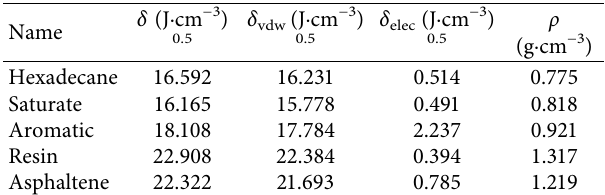
Table 3: Solubility parameters and densities of each component in low-sulfur fuel oil at